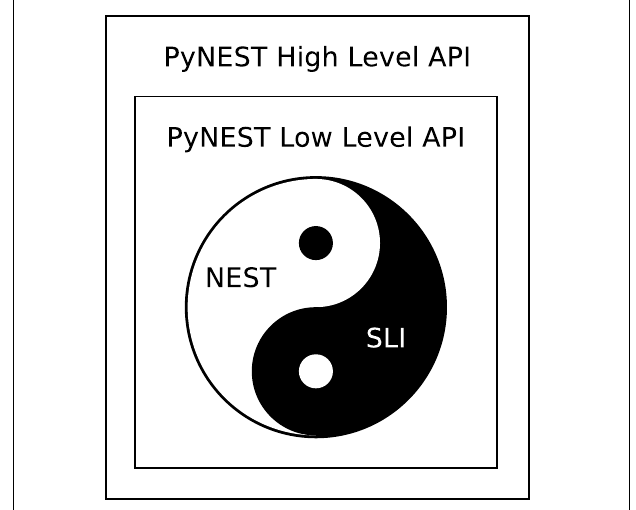
FIGURE 1 | Diagram depicting the design of PyNEST, the Python bindings for the NEST simulator. The inner circle represents the NEST simulation kernel and the SLI interpreter. The simulation kernel of NEST uses private SLI data structures (black dot), and many SLI commands are implemented using private NEST simulation kernel APIs (white dot); this non-separation of concerns is discussed in details in the main text. Taken together, however, they effectively constitute a stable high-level public API to the NEST simulator. The first rectangle that encompasses the circle represents PyNEST low-level (private) API, previously implemented in C ++ and now re-written in Cython. This API provides three primitives to control the SLI interpreter: a primitive to feed a string as a command for the SLI interpreter to run, and two primitives to push objects on the stack and pop objects off the stack. The outer rectangle illustrates PyNEST high-level (public) API, implemented in pure Python. This high-level API uses the low-level API to provide a “pythonic” interface to the functionality of NEST, such as the creation of neurons, wiring routines,